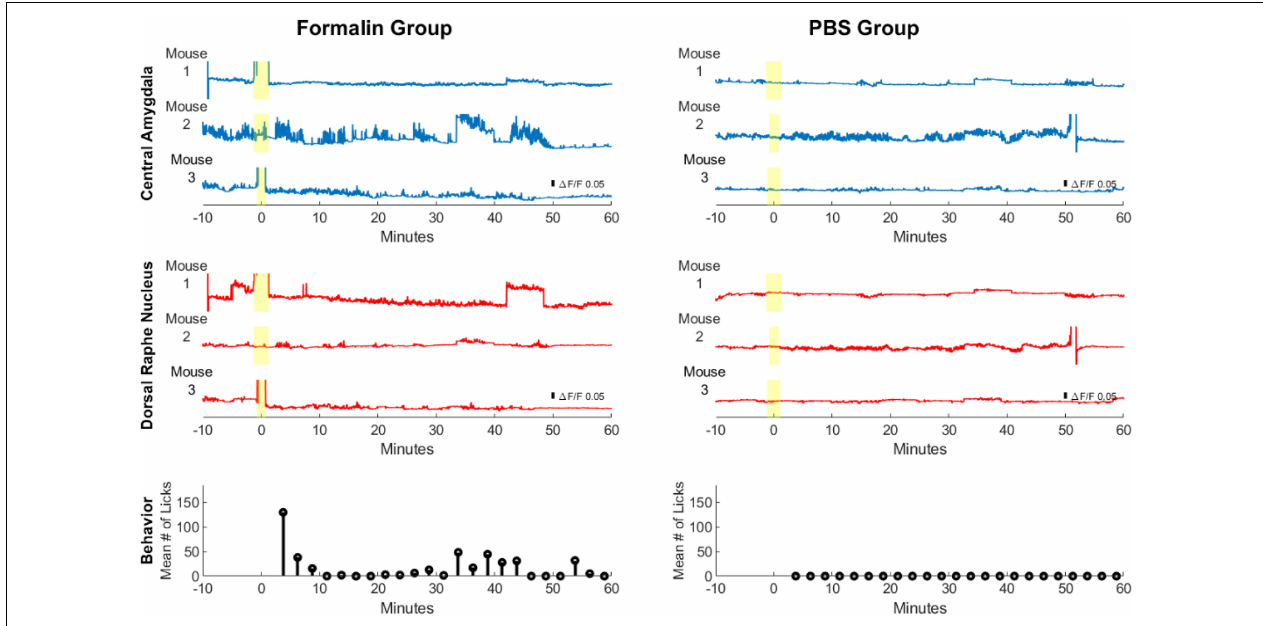
FIGURE 6 | Calcium imaging and behavioral analysis across multiple mice. Brain calcium imaging and behavioral analysis of Formalin- and PBS-injected mice. The yellow highlight marks the injection period. The blue line graphs show calcium measurements of the CeLC across multiple mice, while the red line graphs show calcium measurements of the DRN. At the bottom are the behavioral results for the average number of licks per 2.5 min time block among Formalin mice ( n = 4) and PBS mice ( n =